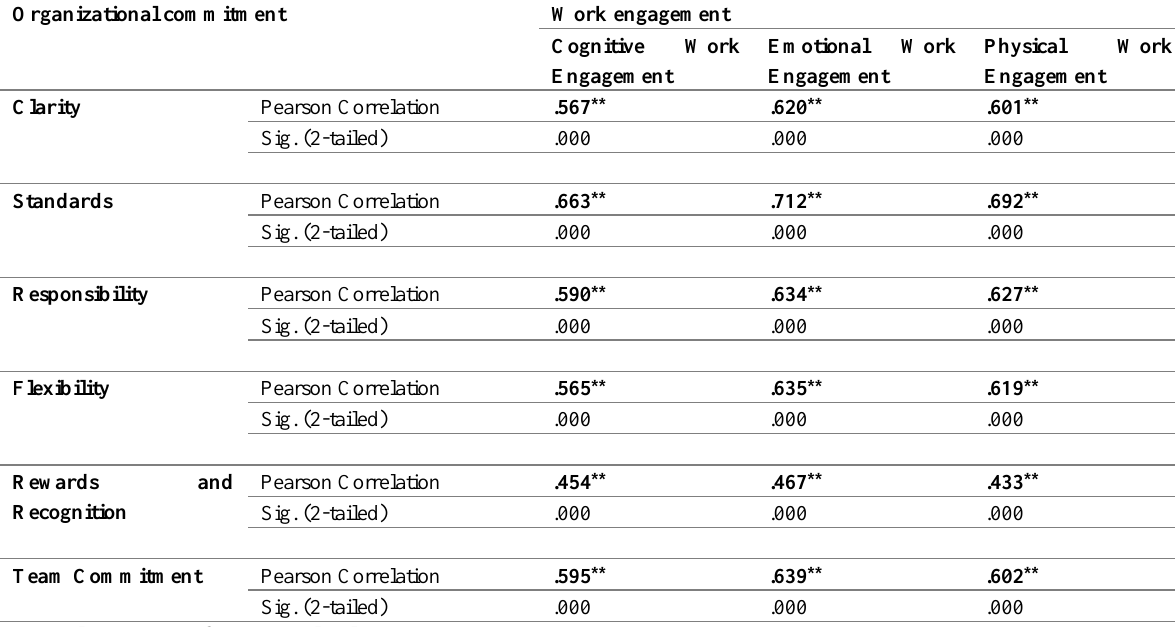
Table 12: Coefficients of correlation on the relationship between the organizational climate and work engagement of employees Organizational